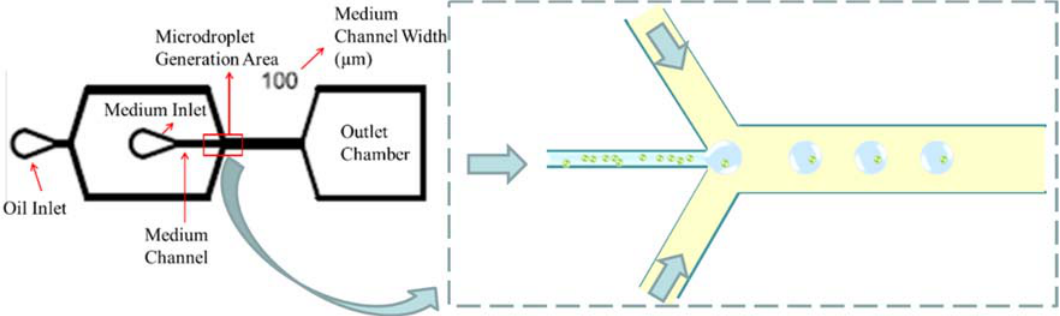
Figure 2. The design concept of microdroplet generation.